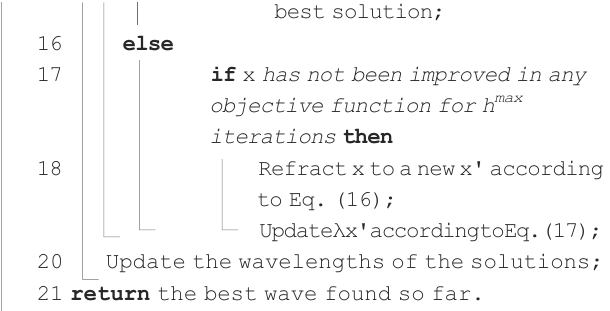
ALGORITHM 2 WWO algorithm adapted for the fuzzy crop planning problem.